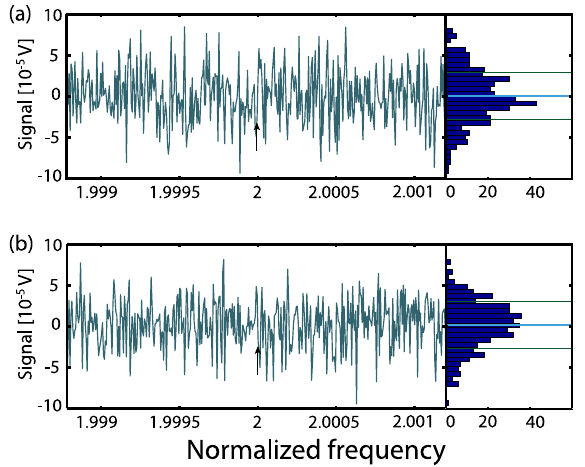
FIG. 4. Cosine (a) and sine (b) Fourier transform around 2 ω The arrow points out the putative signal at 2 ω